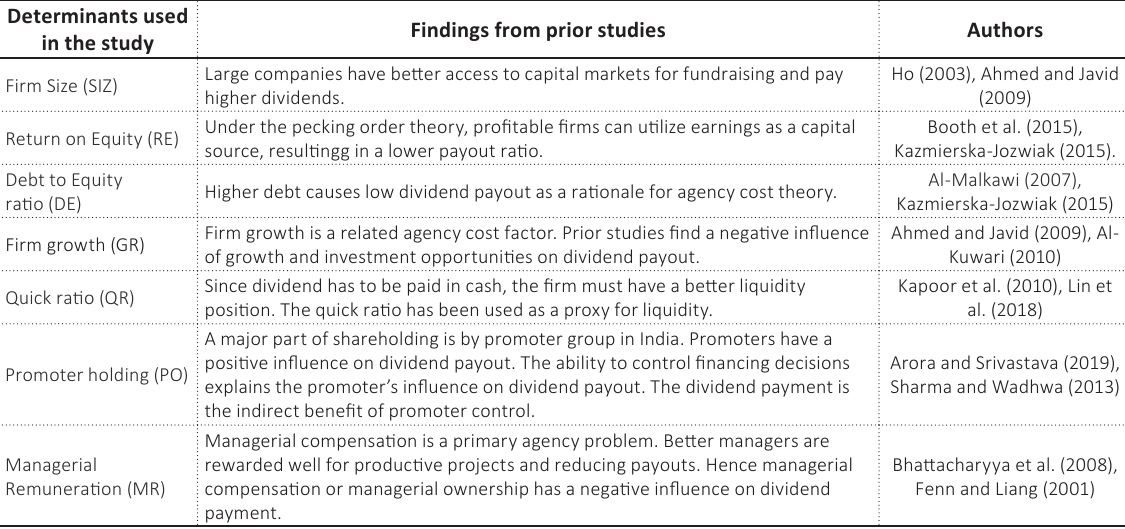
Table 1. Summary of empirical studies on payout policy Determinants